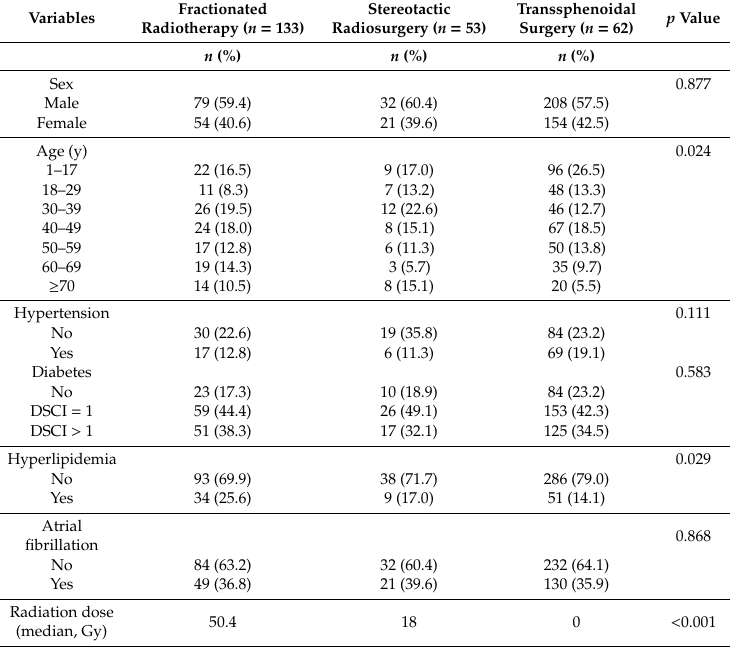
Table 1. Characteristics of patients with nonfunctioning pituitary macroadenomas who received fractionated radiotherapy, stereotactic radiosurgery, or transsphenoidal Surgery. Variables Fractionated Radiotherapy ( n = 133)